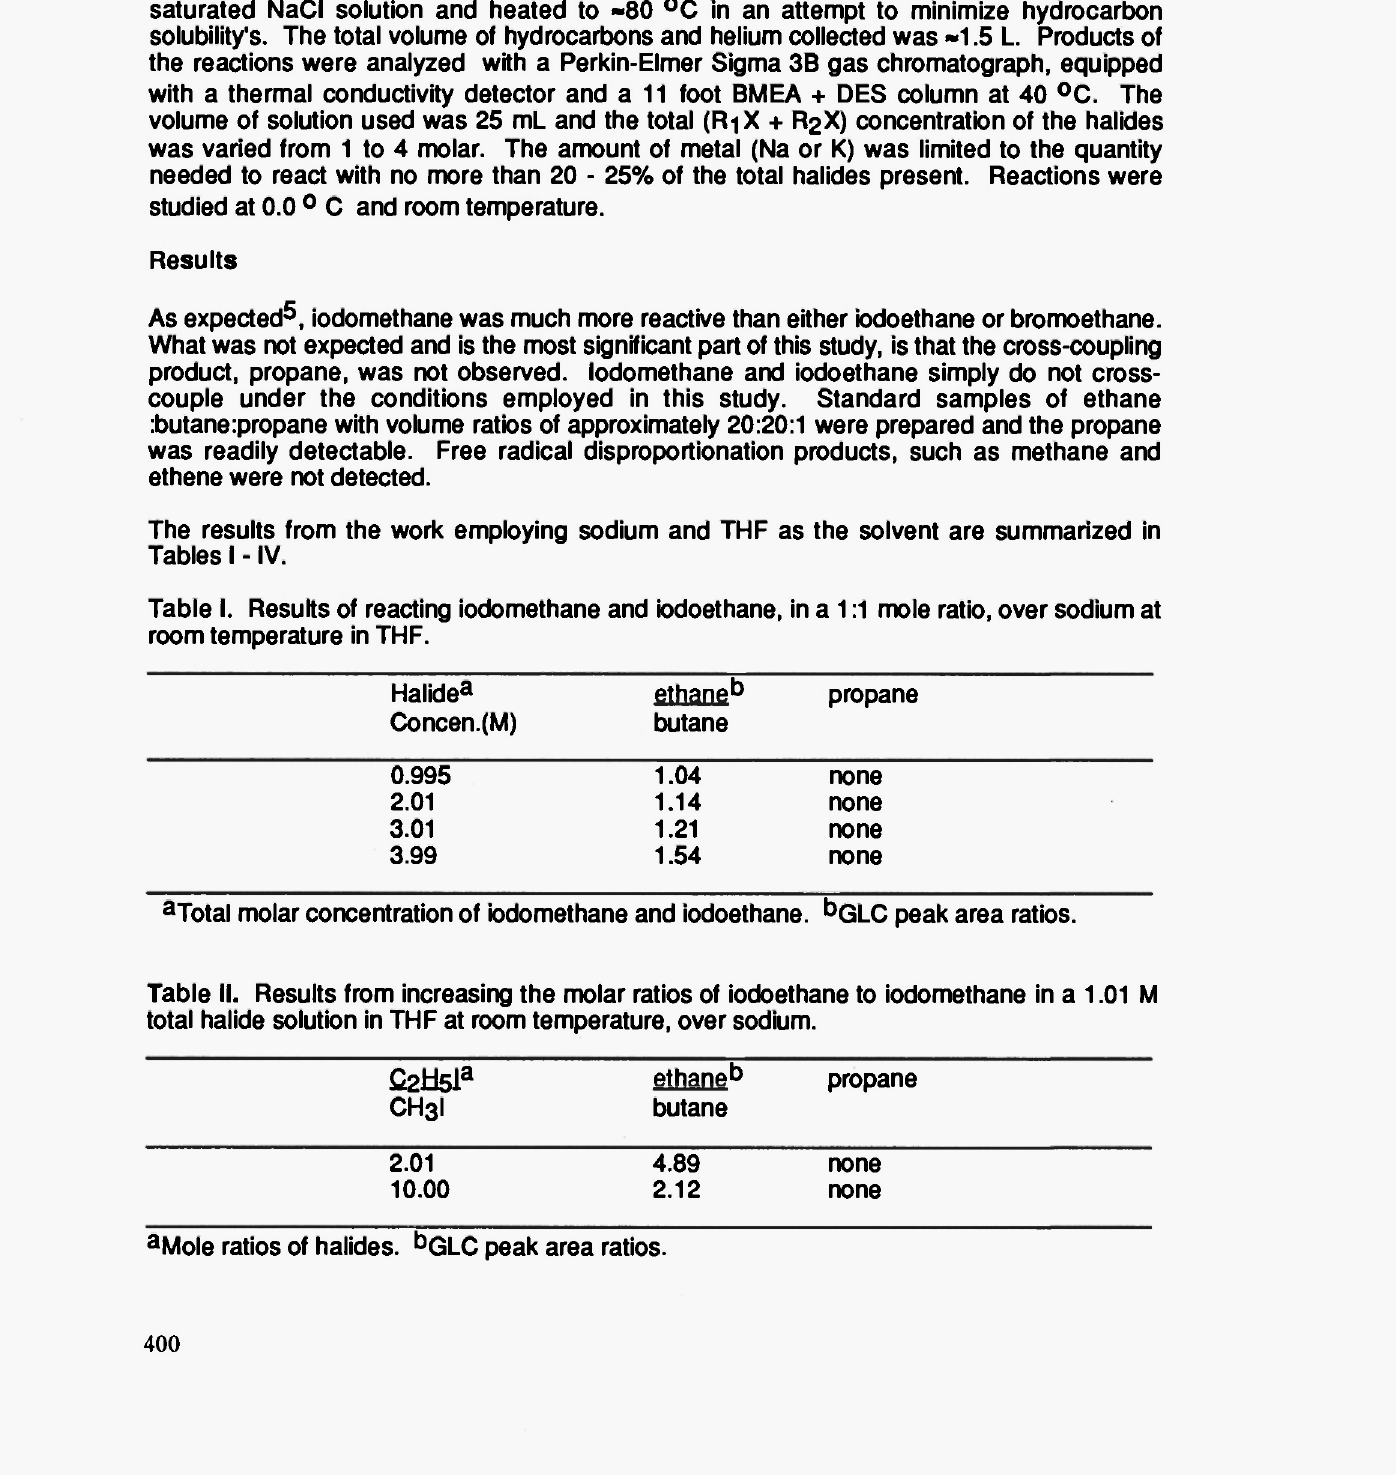
Table I. Results of reacting iodomethane and iodoethane, in a 1:1 mole ratio, over sodium at room temperature in THF.